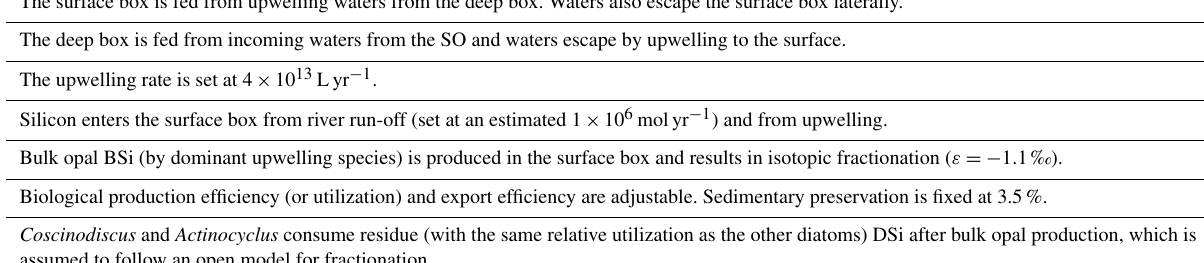
Table 3. Conditions in the box model. The surface box is fed from upwelling waters from the deep box. Waters also escape the surface box laterally. The deep box is fed from incoming waters from the SO and waters escape by upwelling to the surface. The upwelling rate is set at 4 × 10 13 Lyr − 1